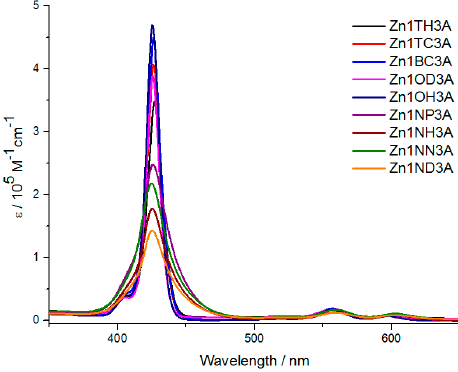
Figure 1. Ultraviolet visible (UV/Vis) spectra of the 1D ‐π‐ 3A porphyrin sensitizers in tetrahydrofuran.